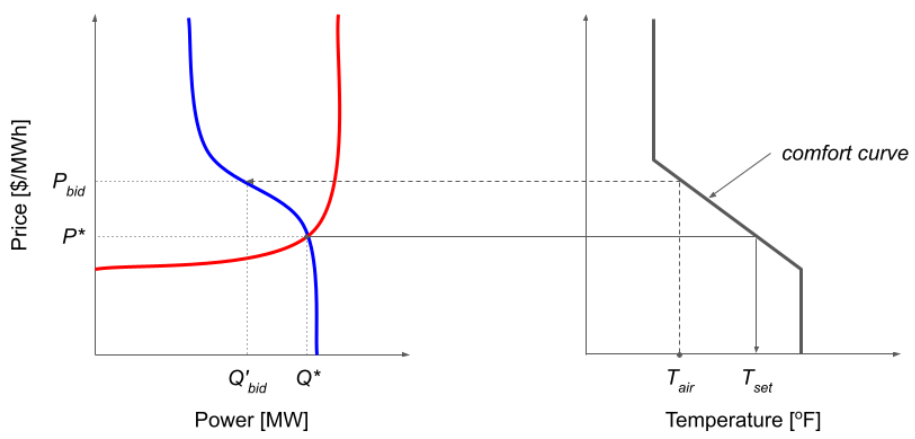
Figure 1. Transactive Double Auction ( left ) and Thermostat Bidding Strategy ( right